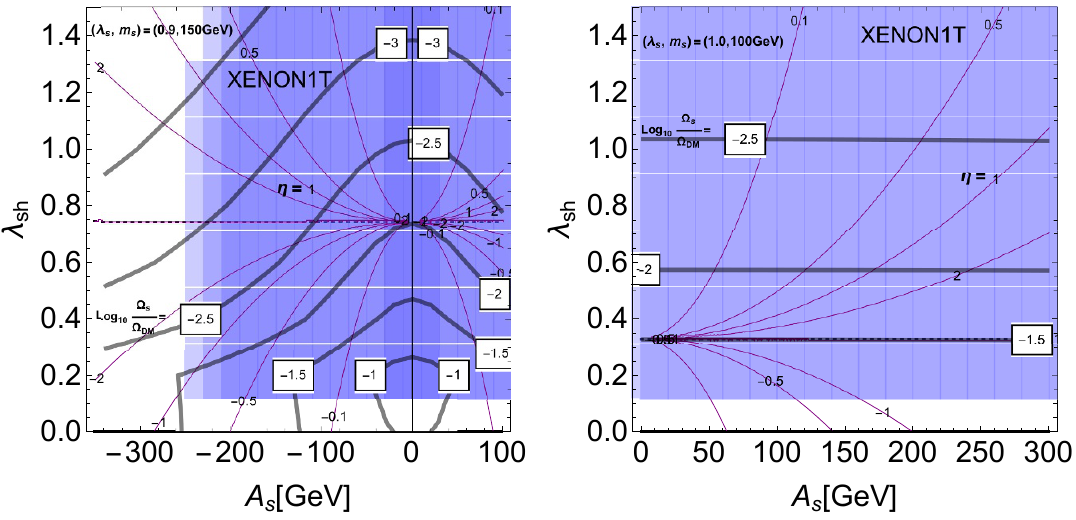
Figure 11 . DM constraints in the ( A s ; (cid:21) sh ) plane by taking parameter sets for ( (cid:21) s ; m s [GeV]) = (0 : 9 ; 150) (left panel) and (1 : 0 ; 100) (right panel) in (cid:12)gure 8. The shaded lighter blue regions are excluded by XENON1T [107]. The contours of the predicted thermal relic density of the model which is normalized by the observed one, log 10 ((cid:10) s = (cid:10) DM ), are plotted by the gray